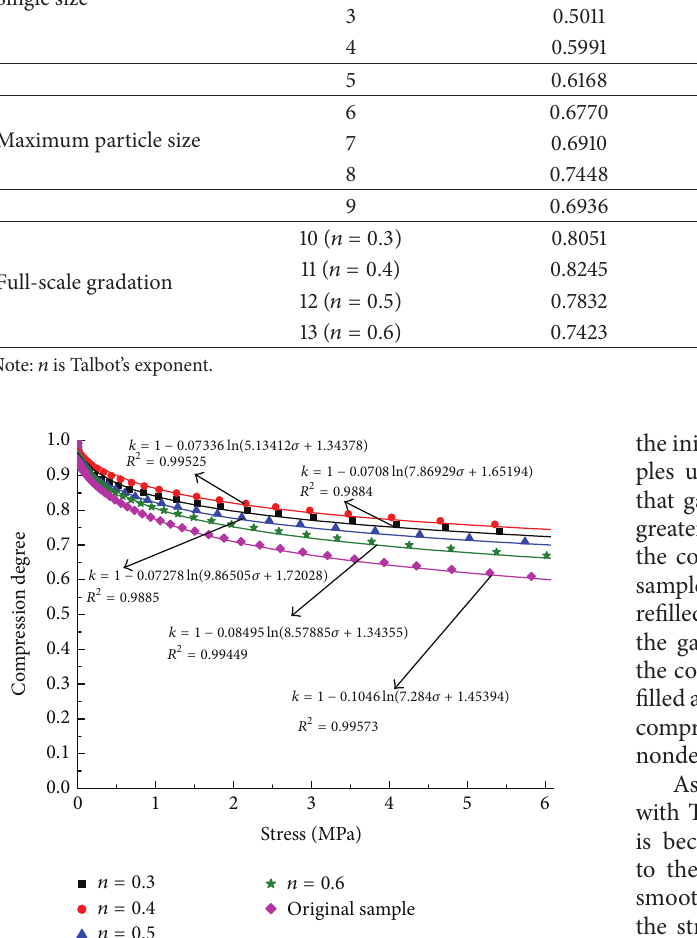
Figure 7: Stress-compression degree for full-scale graded